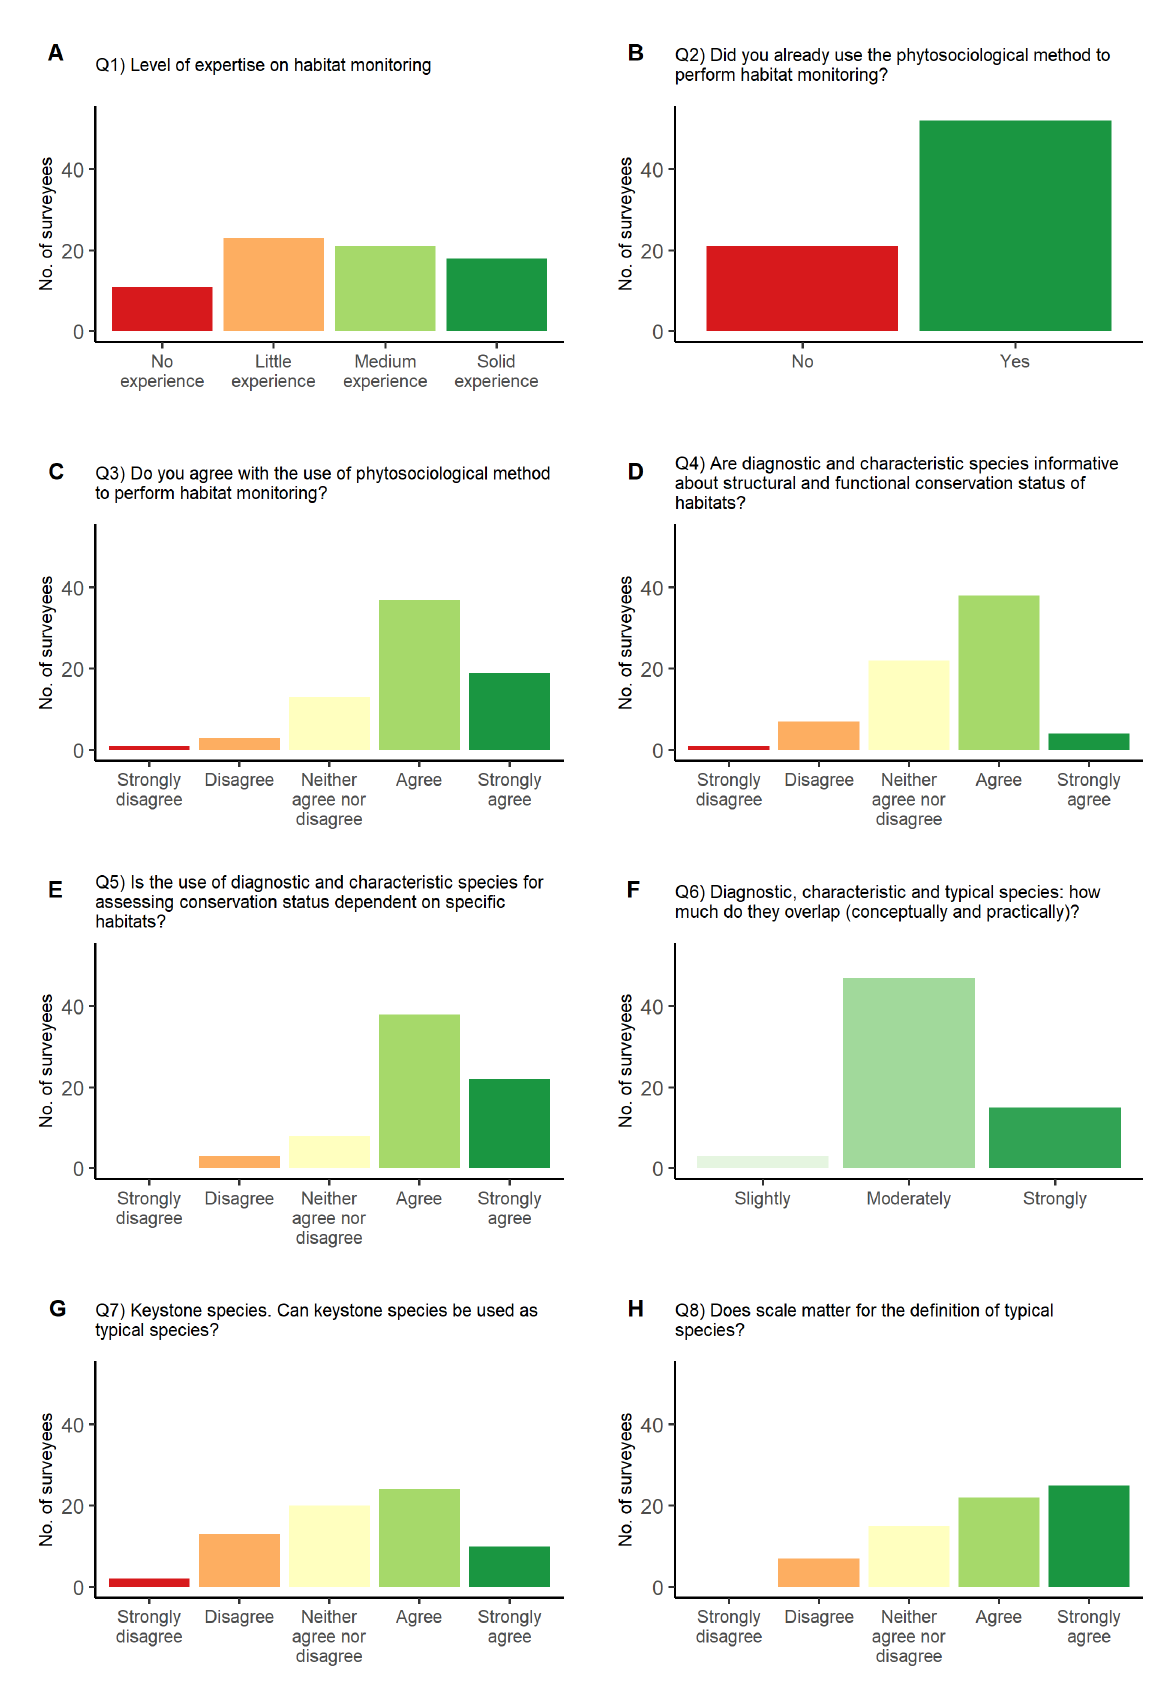
Figure 1. Barplots of the answers to the